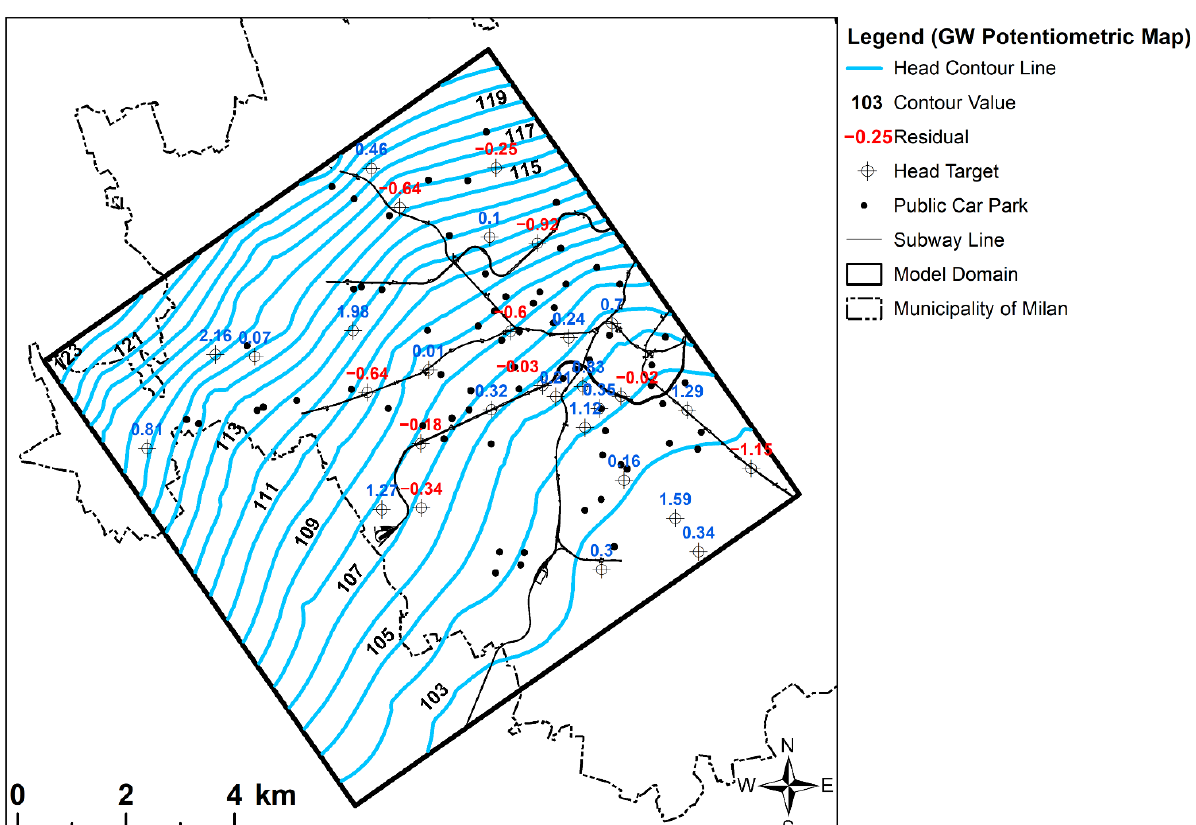
Figure 9. GW potentiometric map of the study